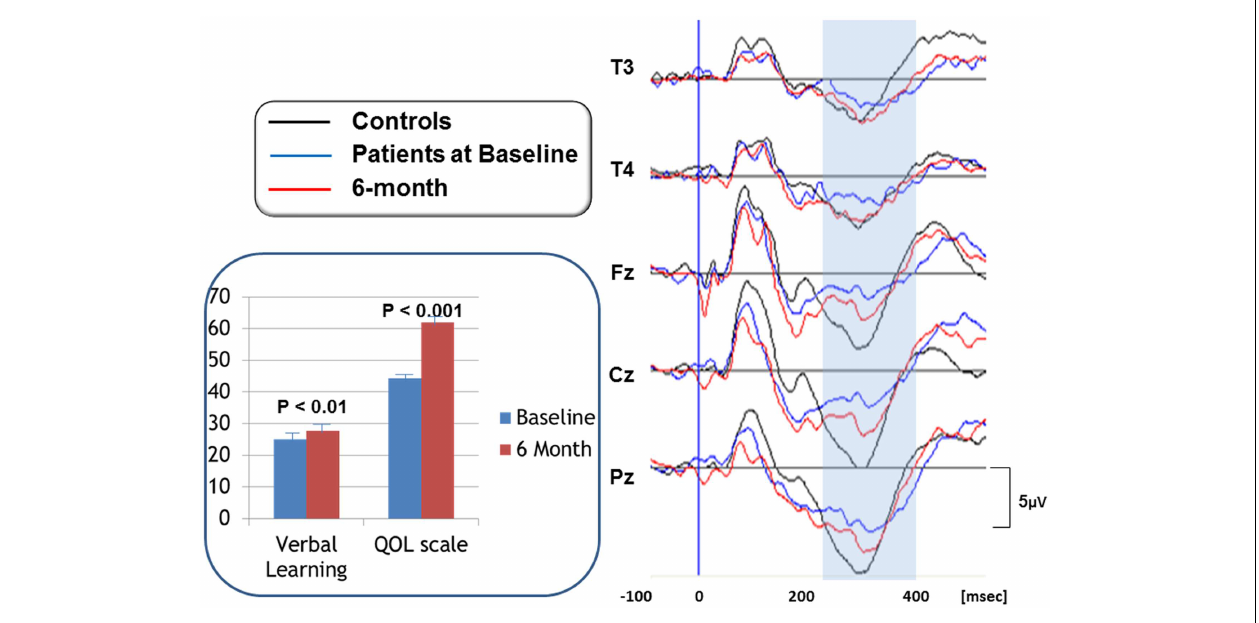
subjects. After 6month treatment with olanzapine, P300 amplitudes were increased, as indicated by redlines. Scores of verbal memory and quality of life were also increased by olanzapine (inset). Bars represent mean + SE.